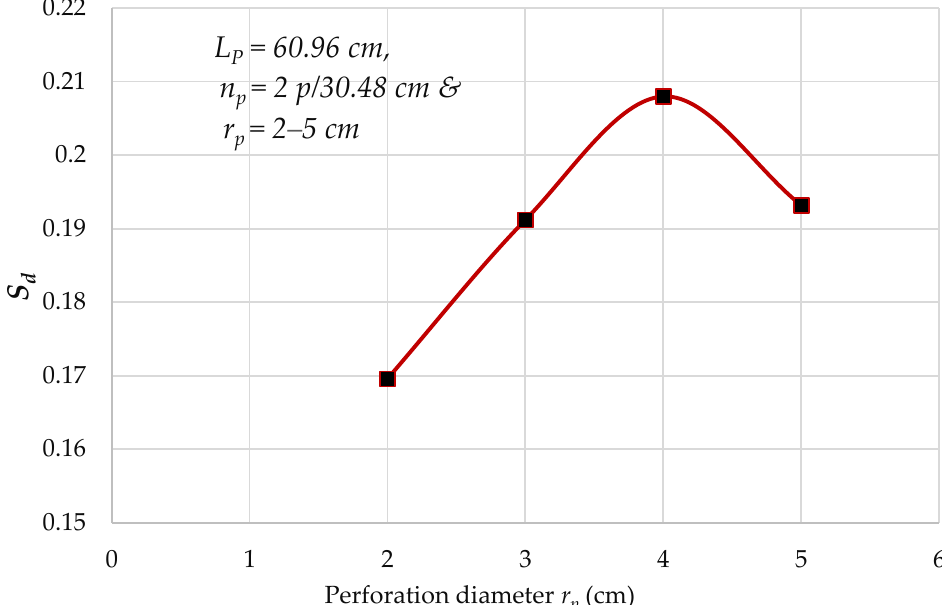
Figure 16. Difference in skin factor values of two perforation orientations with increasing perforation diameter r p (2–5 cm).